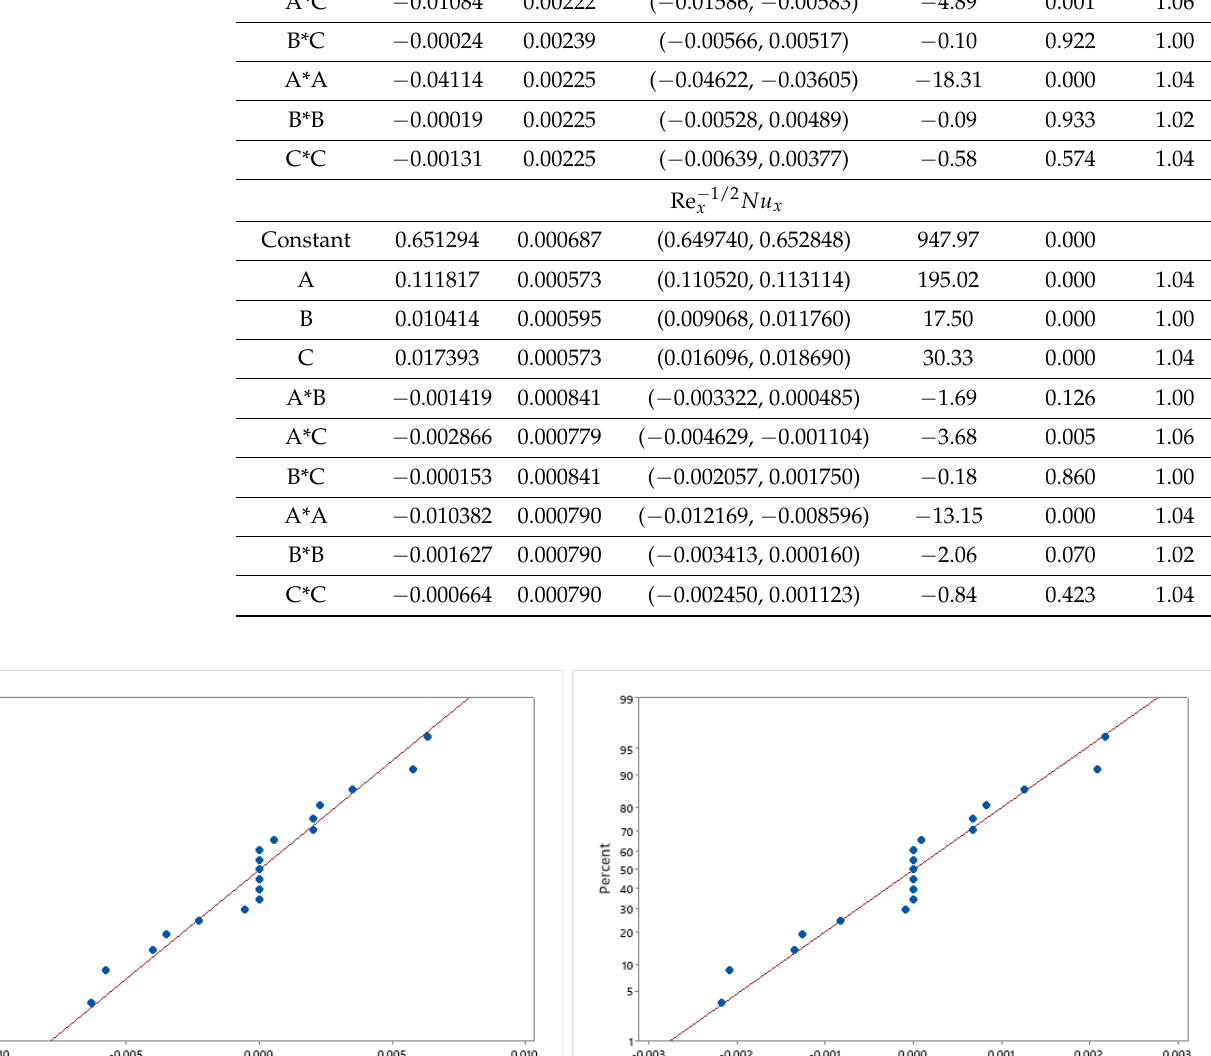
− 1/2 x C f and ( b ) Re